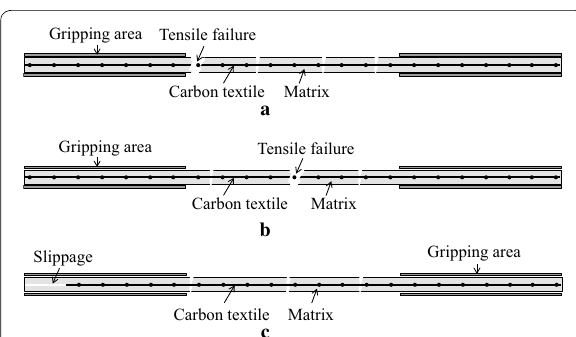
Fig. 5 Failure mode of direct tensile test of TRM test specimens (Leone et al. 2017; Carozzi et al. 2017). a Failure mode A, b Failure mode B, c Failure mode